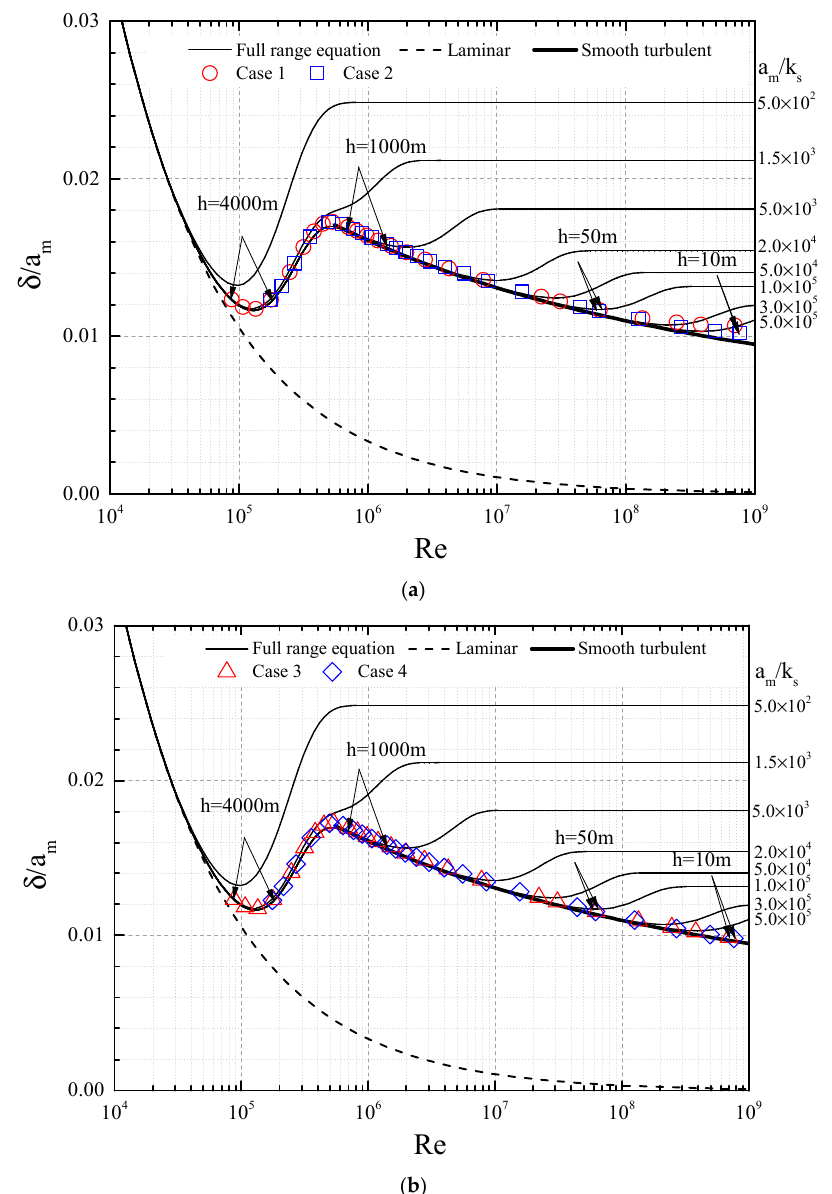
Figure 3. Transitional behavior of boundary layer thickness. ( a ) Case 1, Case 2 ( d = 0.3 mm), ( b ) Case 3, Case 4 ( d = 0.1 mm).